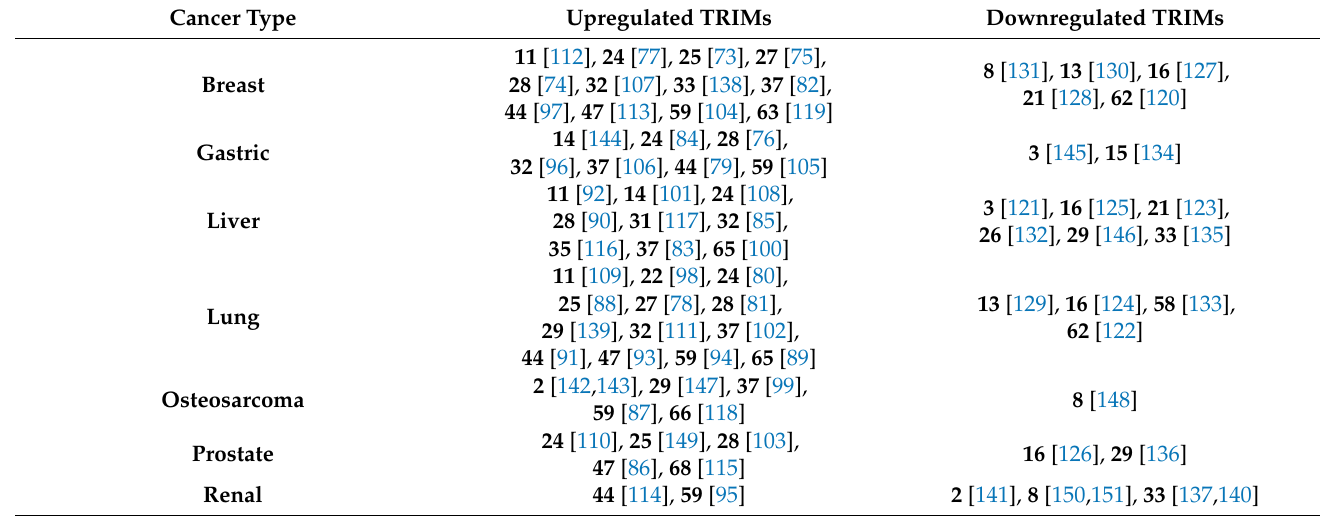
Table 1. TRIM proteins in tumors. Tripartite motif (TRIM) proteins described in the manuscript are listed based on their expression levels in the main cancer types